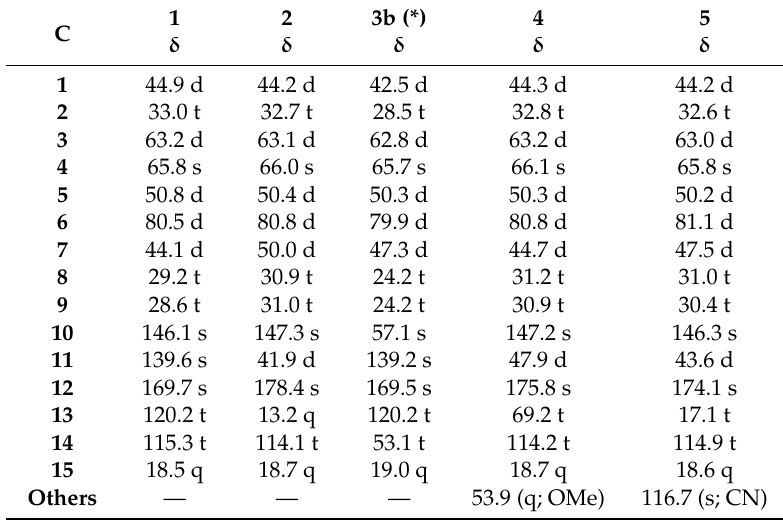
Table 3. 13 C-NMR data of compounds 1 – 5 in CDCl 3 (600 MHz; TMS as internal